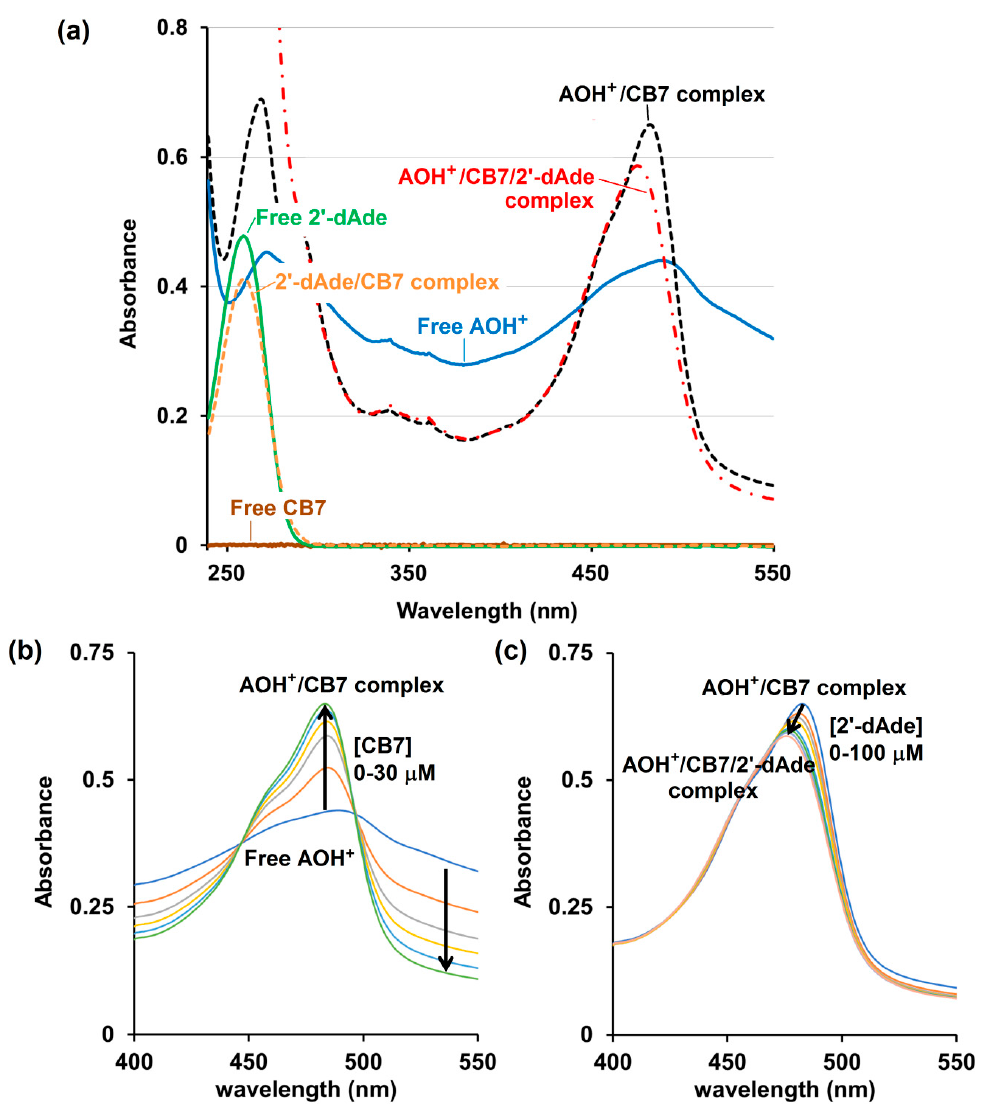
Figure 5. UV-Visible spectrum (JASCO V-530, 10 mM ammonium acetate buffer, pH 4.0) of ( a ) free CB7 (10 μ M, solid brown line), free protonated acridine orange (AOH + , 10 μ M, solid blue line), free 2 ′ -deoxyadenosine (2 ′ -dAde, 30 μ M, solid green line), 2 ′ -dAde/CB7 complex (30/30 μ M, respectively, orange dash line), AOH + /CB7 complex (10/30 μ M, respectively, black dash line) and AOH + /CB7/2 ′ - dAde complex (10/30/100 μ M, respectively, red dash dot line); ( b ) AOH + (10 μ M) after being titrated with CB7 and ( c ) addition of 2 ′ -dAde to the AOH + /CB7 complex (10/30 μ M, respectively).